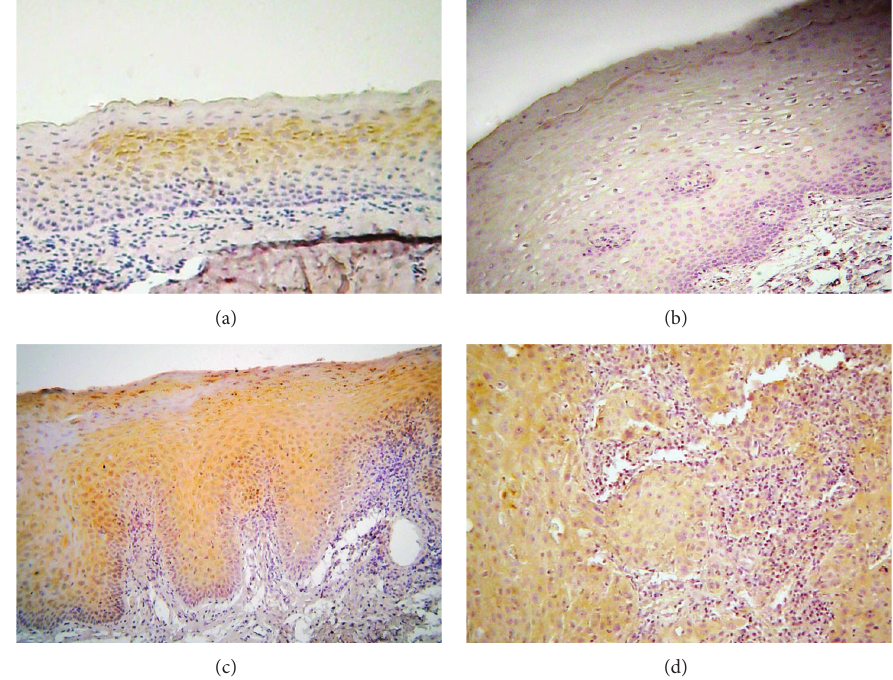
Figure 4: Immunohistochemical expression of phosphorylated mTOR (p-mTOR)in selected cases of (a) oral lichen planus (OLP), (b) normal mucosa (NM), (c) oral leukoplakia (OL), and (d) oral squamous cell carcinoma (OSCC) (immunohistochemistry, 100x